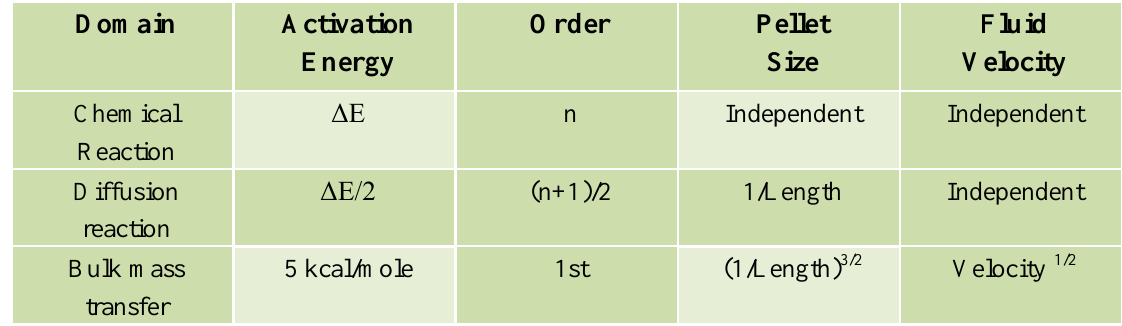
Table 5. Observed versus actual behavior for catalytic